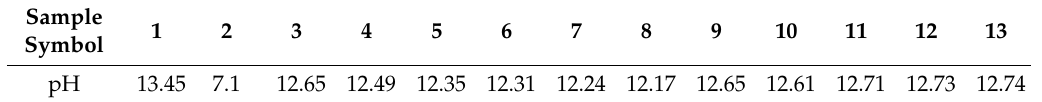
Table 2. pH of the acrylate-silicate mixtures before the polymerization. Sample Symbol